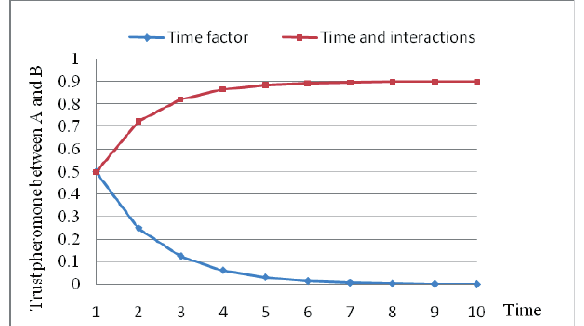
Fig. 3. Variation of trust pheromone with time and interactions between A and